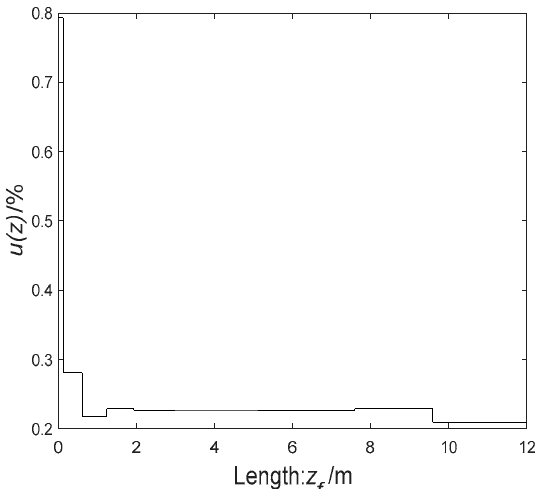
Figure 10. Optimal control trajectory ( N =